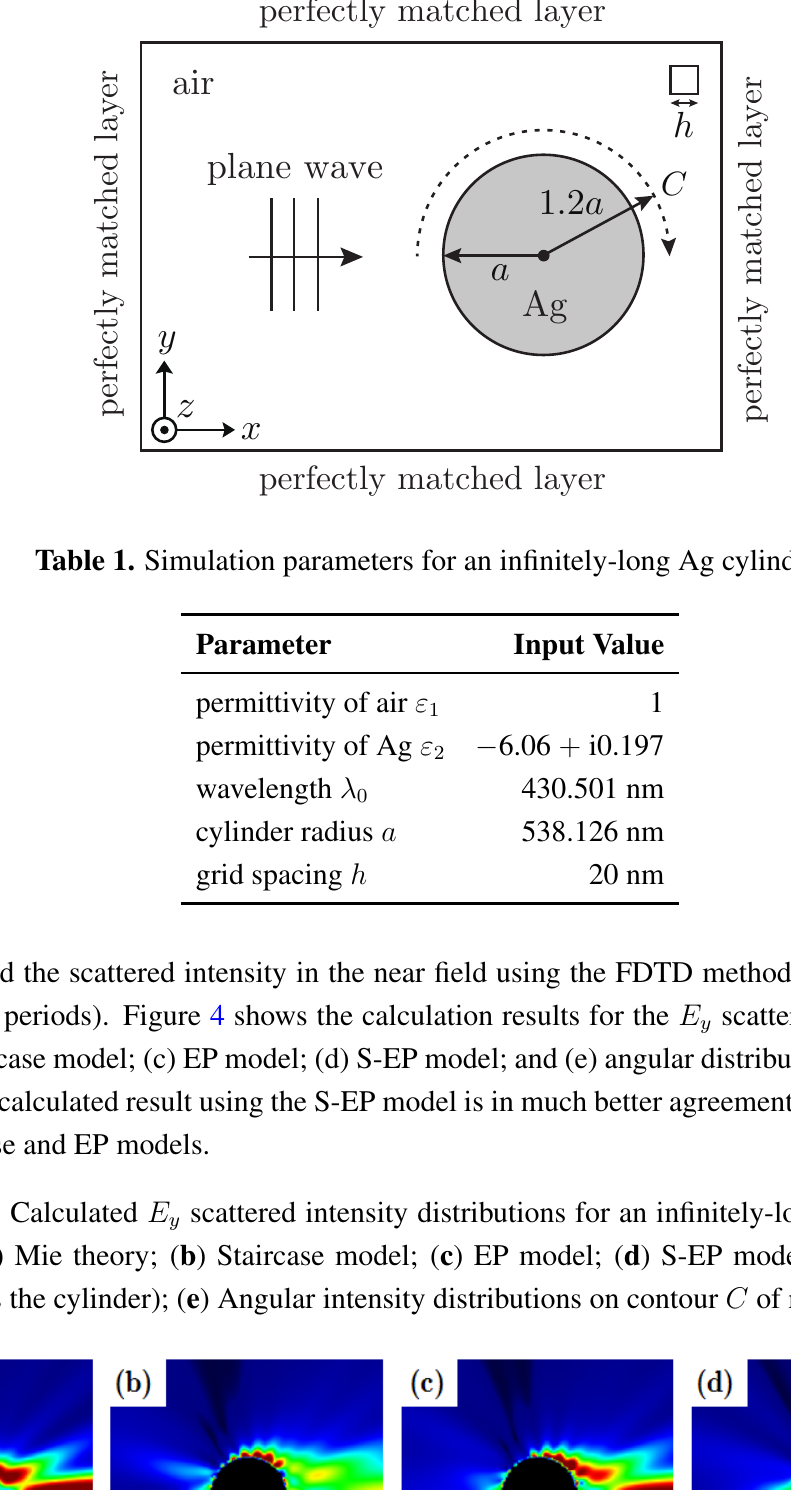
Figure 3. Simulation setup for an infinitely-long Ag cylinder. Incident TM polarization ( a = radius, h = grid spacing). Ag cylinder (gray region) is immersed in air (white region). FDTD results are compared with Mie theory on dotted contour C .